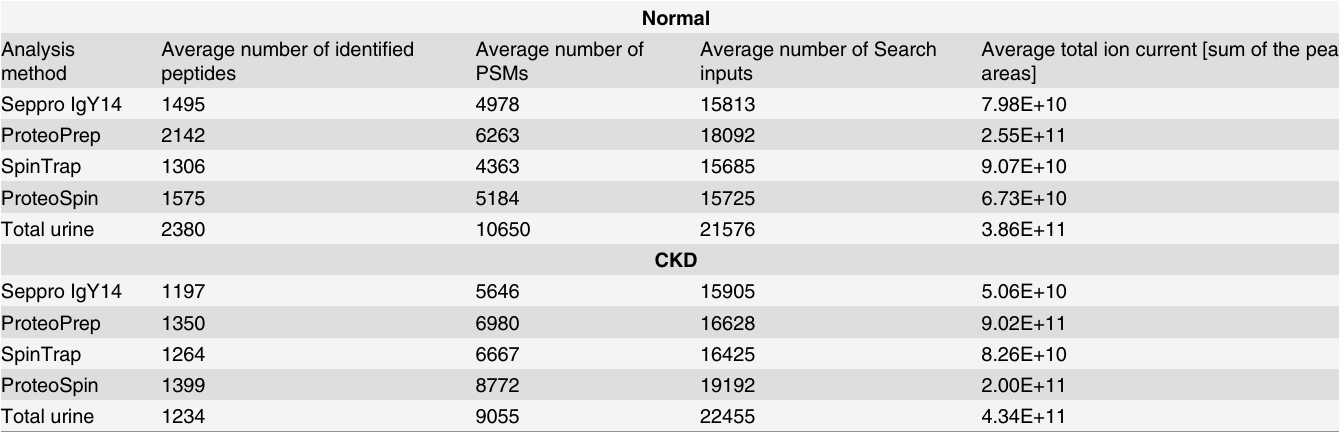
Table 2. Comparison of the number of peptide identifications, PSMs, search inputs and TICs for normal and CKD sample.